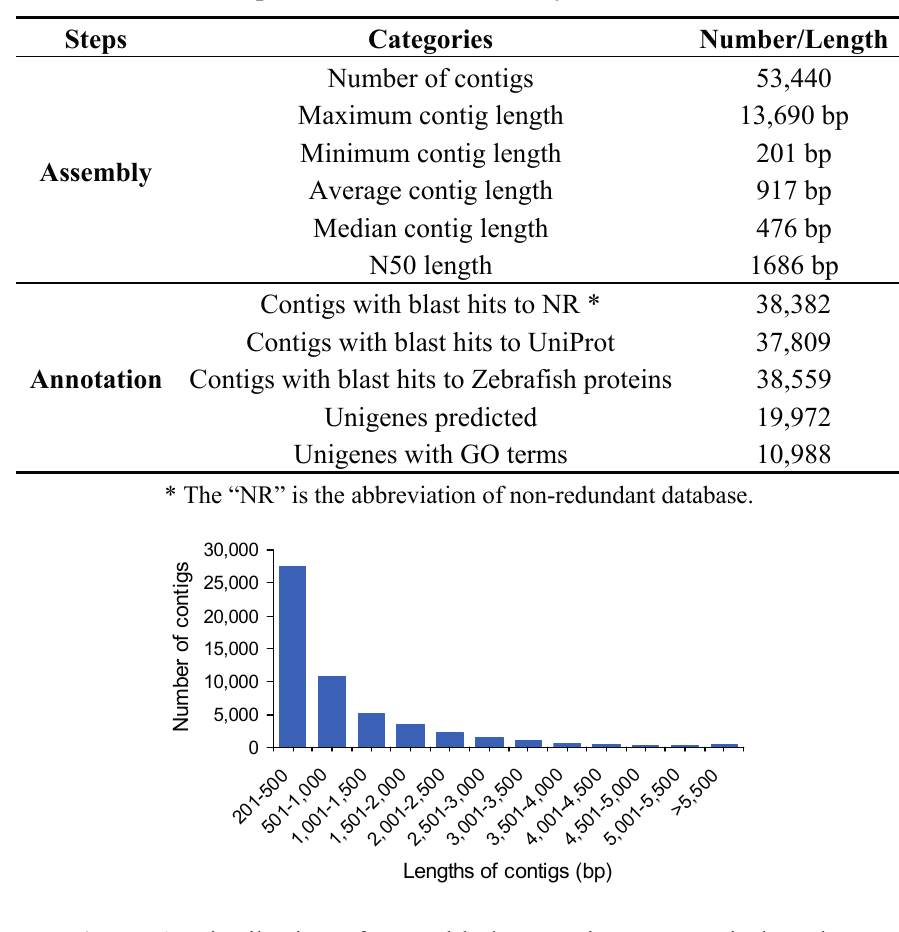
Figure 1. Distribution of assembled transcriptome contig